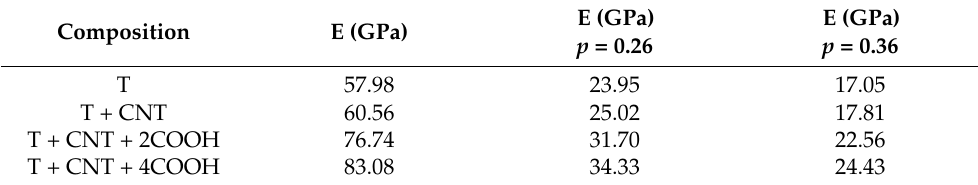
Table 3. Young’s modulus and